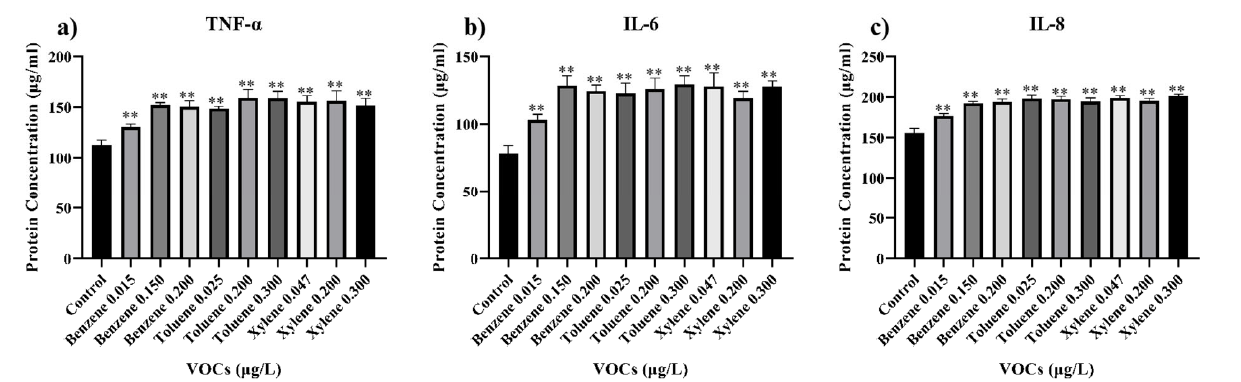
Figure 4. The ELISA test was used to detect the concentrations of ( a ) tumor necrosis factor- α (TNF- α ), ( b ) interleukin-6 (IL-6), and ( c ) interleukin-8 (IL-8) in the supernatant of BEAS-2B cells cultured with varying concentrations of BTX. The data were collected after incubating the cells with different concentrations of BTX in the culture medium for 24 h. The ratio of DMSO to cell culture medium is 0.05%. ** p < 0.01.